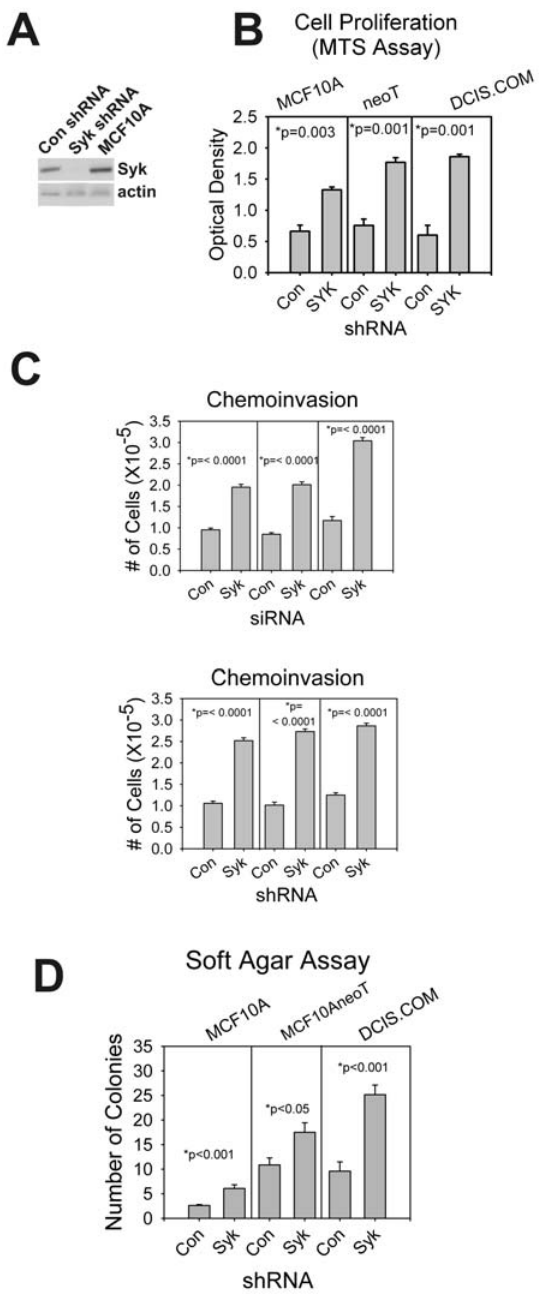
Figure 3. siRNA and shRNA knockdown of Syk enhances chemoinvasion and anchorage independent proliferation. (A) MCF10A, MCF10AneoT, and DCIS.com cells were transduced with Syk or control shRNA in a lentiviral vector. Western blot analysis of puromycin- selected cell populations is shown. (B) The MTS proliferation assay revealed that shRNA cell lines behave similarly to the siRNA transiently transfected cells with respect to Syk knockdown; cell proliferation was enhanced. (C) Chemoinvasion assays were performed in parallel using cells transiently transfected with control or Syk siRNA or stably transduced with lentiviral control or Syk shRNA. Loss of Syk increases chemoinvasion in every case. (D) . In soft agar assays, each of the Syk shRNA knockdown cell lines experienced increased colony formation. Representative images are shown in Figure S3. (B–D) Data are represented as means + / 2 SEM. P values are significant by the student’s t-test for each cell line.